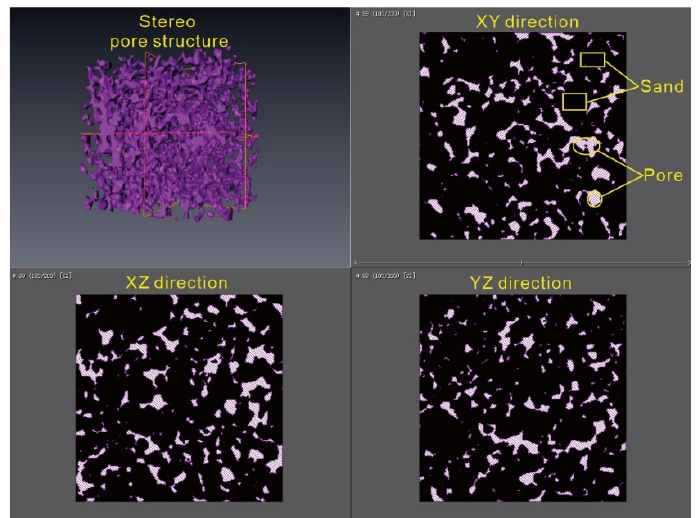
Figure 6. X -ray computed tomography (CT) scan: 2D images of the sample at different sections.